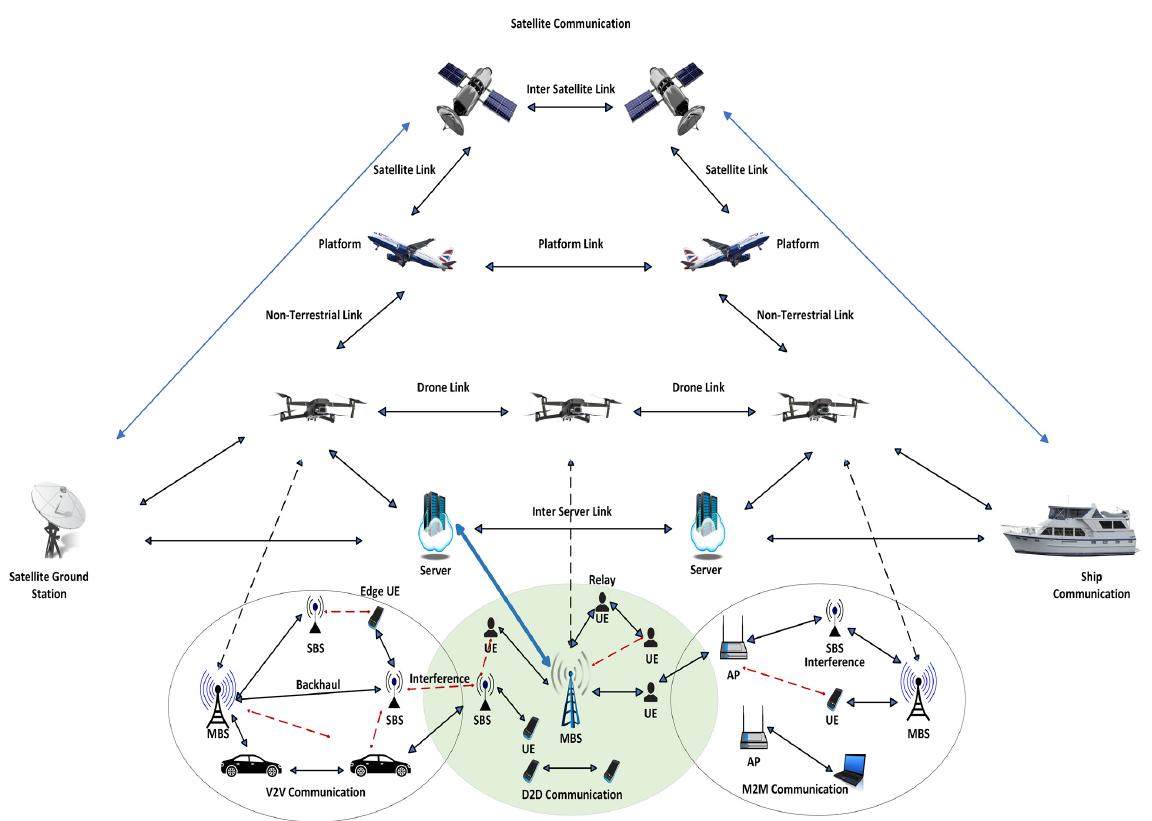
Figure 2. The system structure of future HetNets.